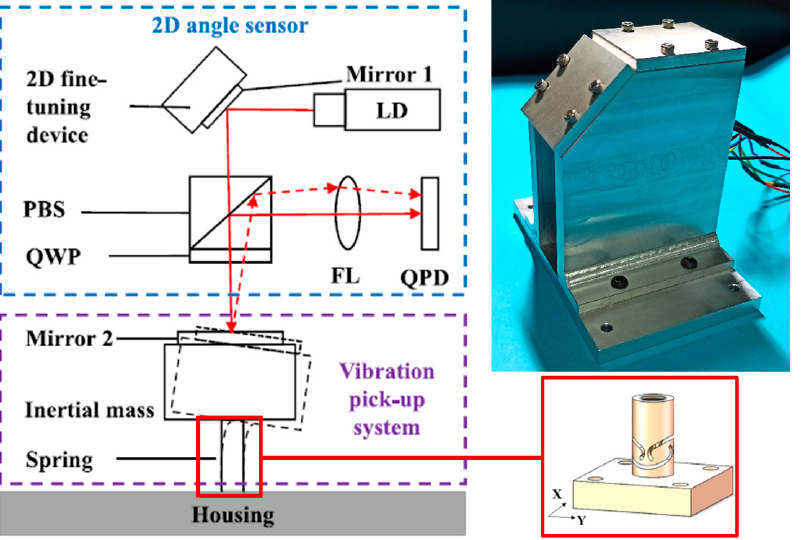
Figure 7. Accelerometer based on the LAC: ( a ) 2D angle sensor and ( b ) 2D accelerometer based on a DVD pickup head. Figure ( a ) is reprinted with permission from Ref. [26]. Copyright 2019 Springer